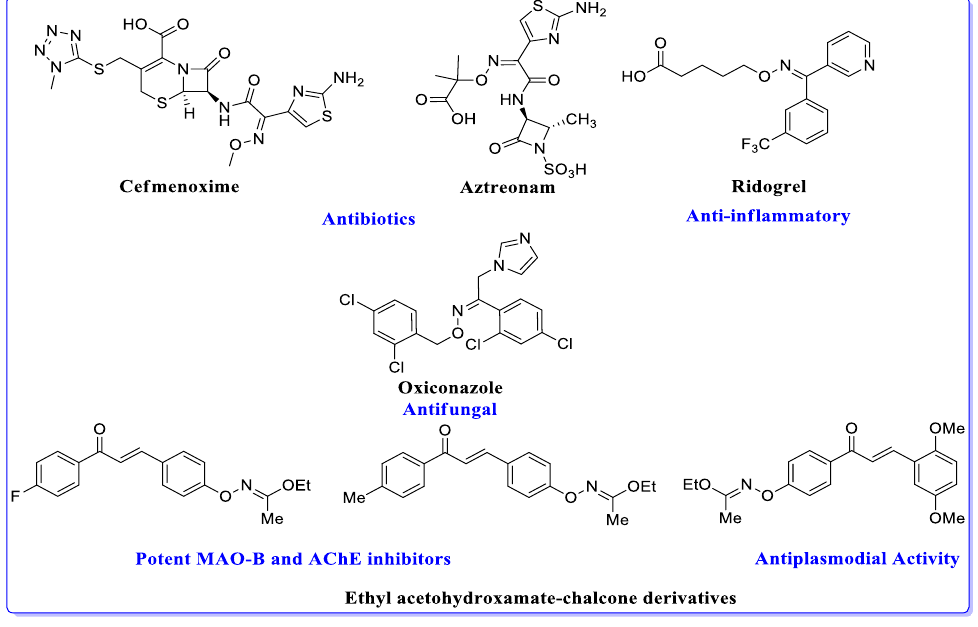
Figure 2. Structures of various biologically active compounds containing oxime moieties.